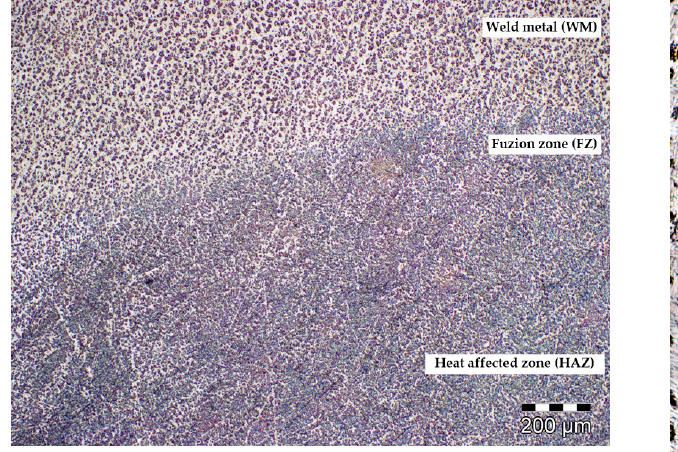
Figure 10. Microscopy image of the hip prosthesis reconditioning zone: ( a ) 100×; ( b ) 50×.